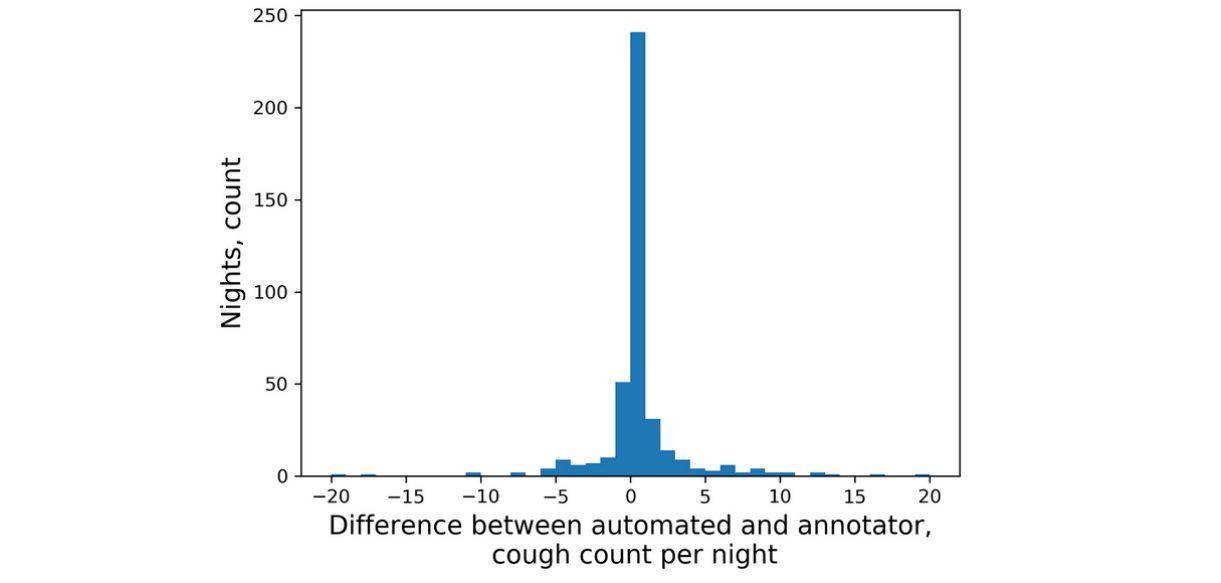
Figure 5. Histogram of the differences between automated and annotator cough counts per night.